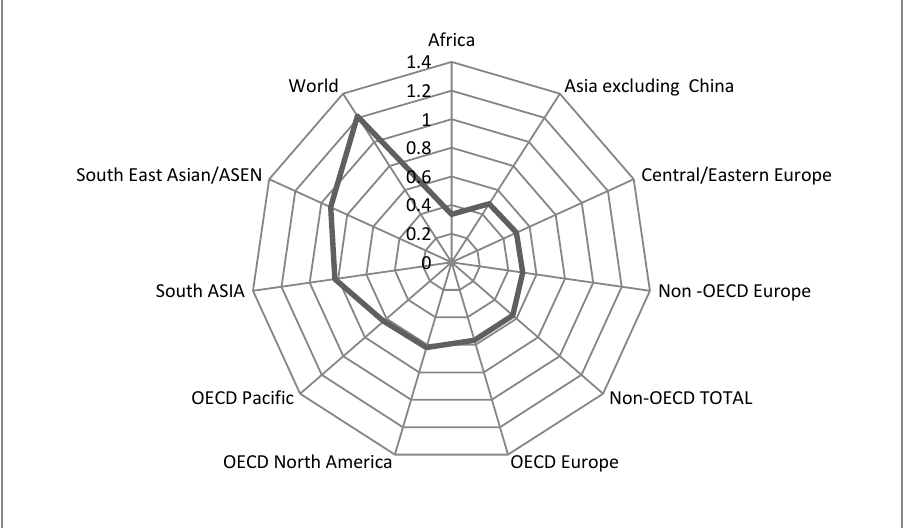
FIGURE 4: GEFs of different continents and subcontinents (2008)